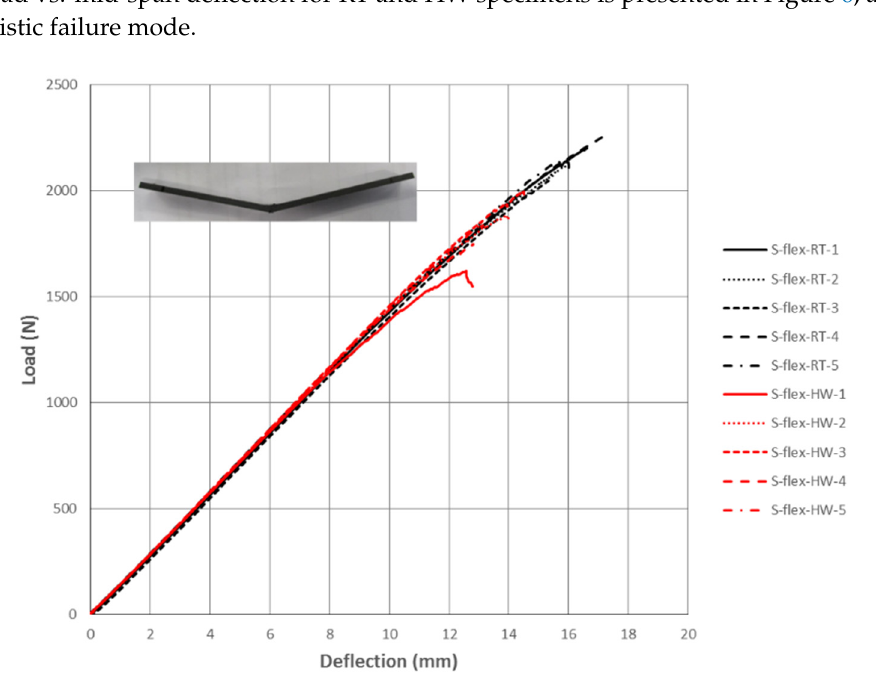
Figure 6. Static flexure: load-deflection data and typical failure mode.